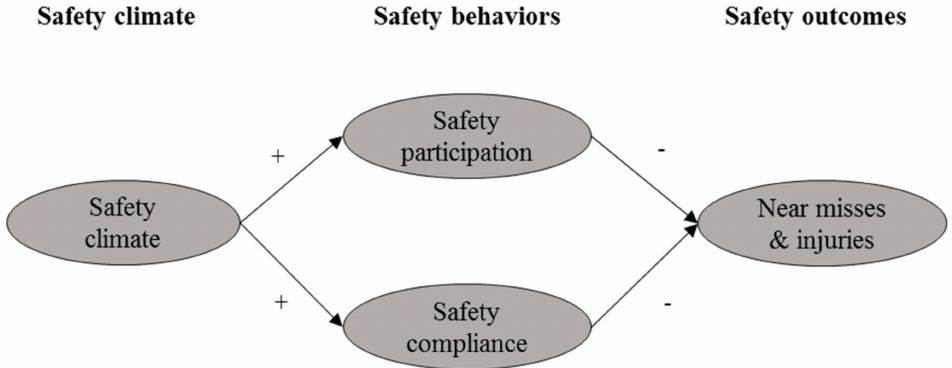
Figure 1. Initial theoretical model and research